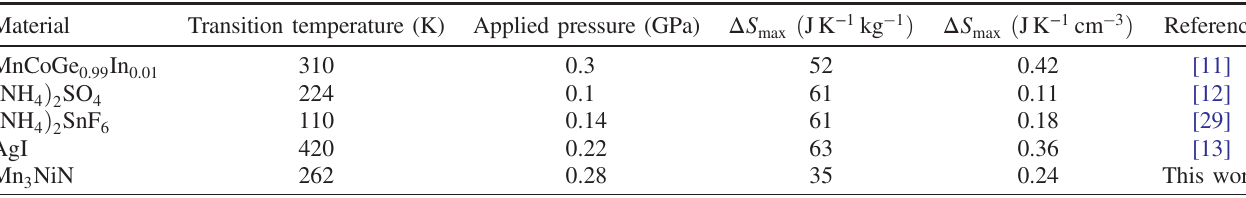
TABLE I. Pressure-driven entropy changes for selected state-of-the-art barocaloric materials, listing their transition temperatures, applied pressures, and corresponding entropy changes normalized by mass or volume. Entries for ð NH 4 Þ 2 SO 4 and AgI represent reversible effects. Other entries represent irreversible effects. Entropy changes are obtained from quasidirect calorimetric methods for all entries, expect for MnCoGe 0 In 0 where entropy changes are estimated from pressure-dependent neutron diffraction. . 99 . 01